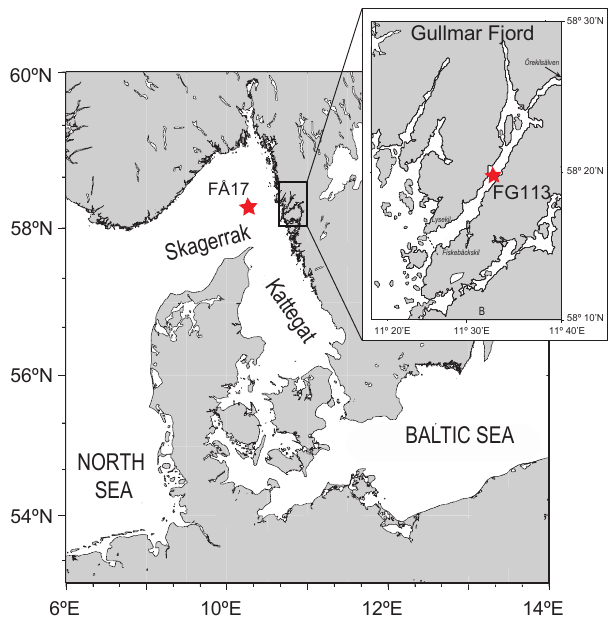
Fig. 1. Map showing the locations of sites FÅ17 and FG113 (inset) where samples were collected. Site FÅ17 is located in the Skager- rak, while site FG113 is from the deepest central part of the Gullmar Fjord.